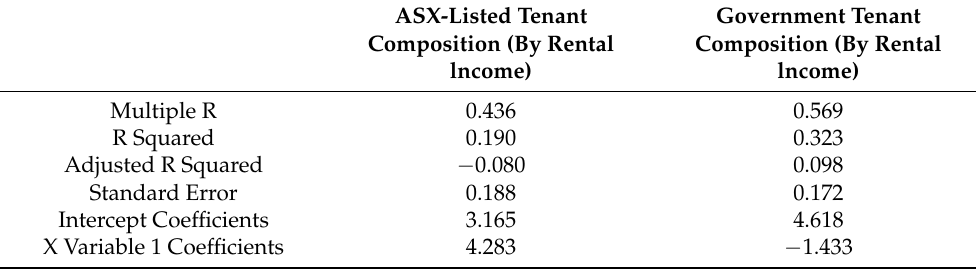
Table 8. Regression results of tenant